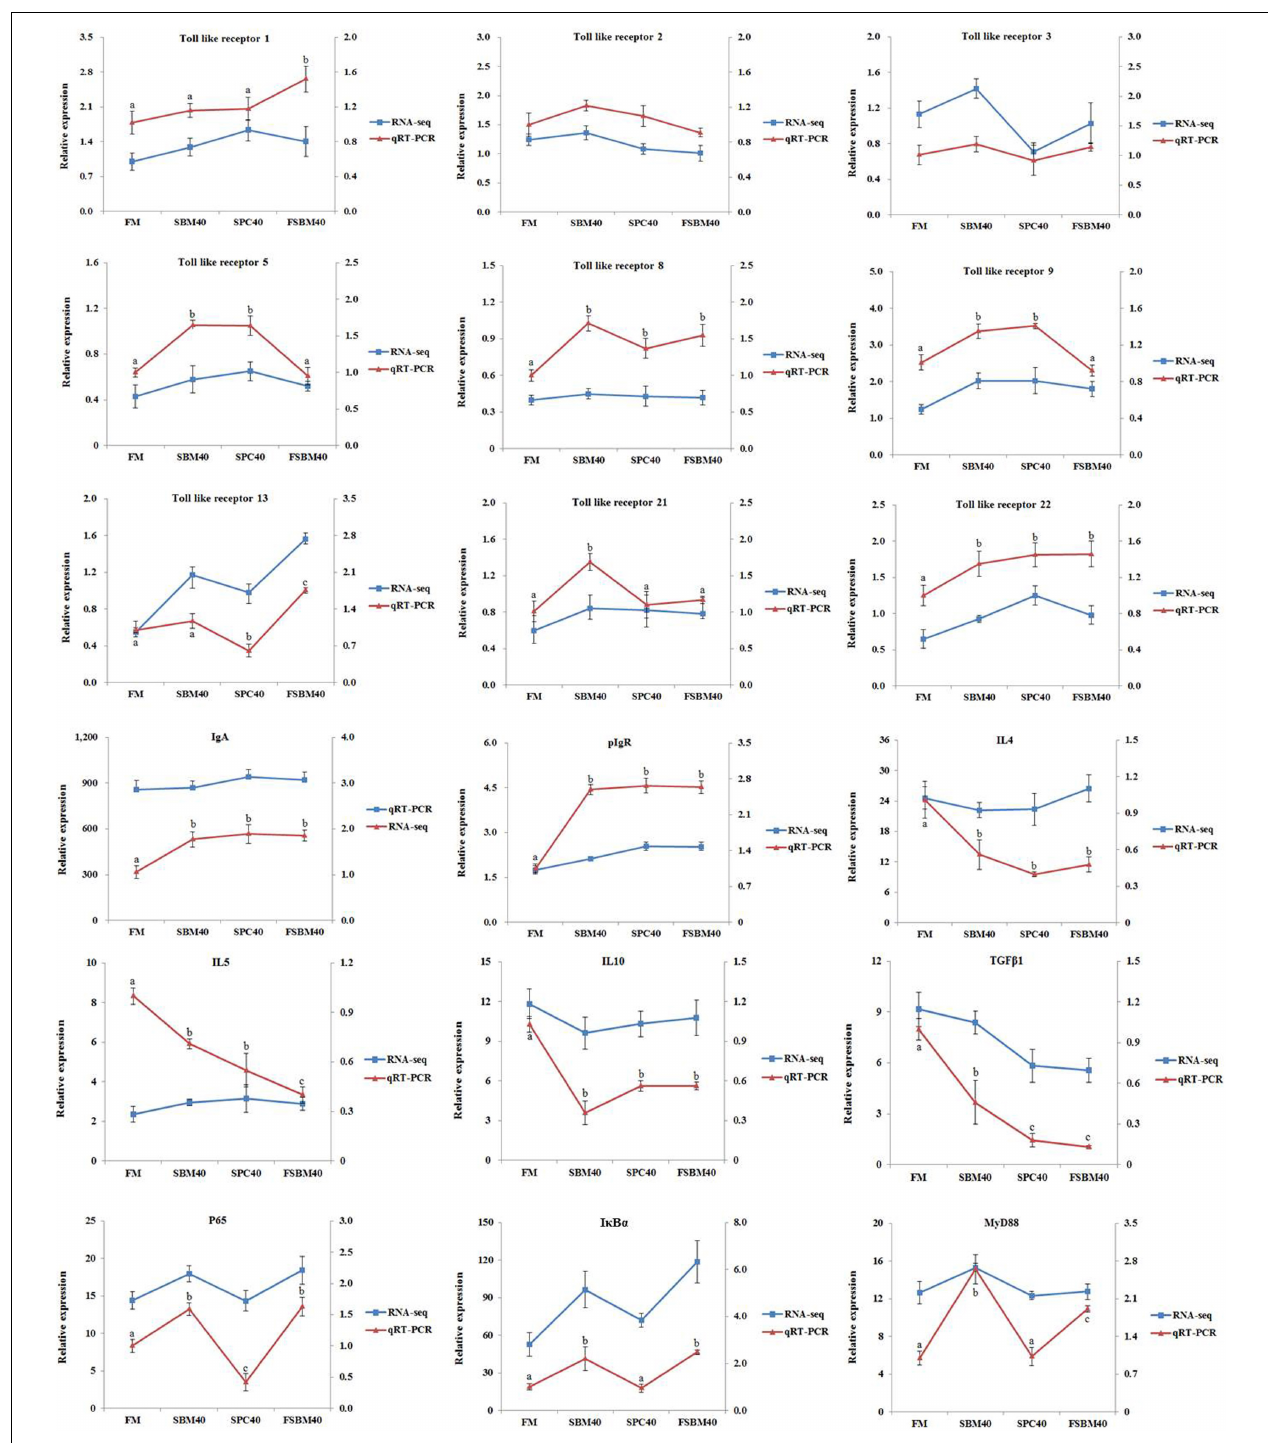
FIGURE 10 | Comparison of the RNA sequencing (RNA-Seq) and the quantitative reverse transcription PCR (RT-qPCR) results. In order to validate the RNA-Seq results, RT-qPCR was used to detect the gene expression levels of the TLR/myD88/NF- κ B pathway and the intestinal immune network for IgA production pathway in the distal intestine (DI) tissues of the pearl gentian grouper. The mRNA expression level in RT-qPCR was normalized by β -actin . The relative expression level in the RNA-Seq analysis was calculated by the FPKM (fragments per kilobase of transcript per million mapped reads) value. The statistical results were expressed as the mean ± SD. Different letters assigned to the lines represent significant differences among the groups at P < 0.05. FM , fish meal control group; SBM40 , 40% soybean meal (SBM) protein replacement level for FM protein; SPC40 , 40% soybean protein concentrate (SPC) protein replacement level for FM protein; FSBM40 , 40% fermented soybean meal (FSBM) protein replacement level for FM